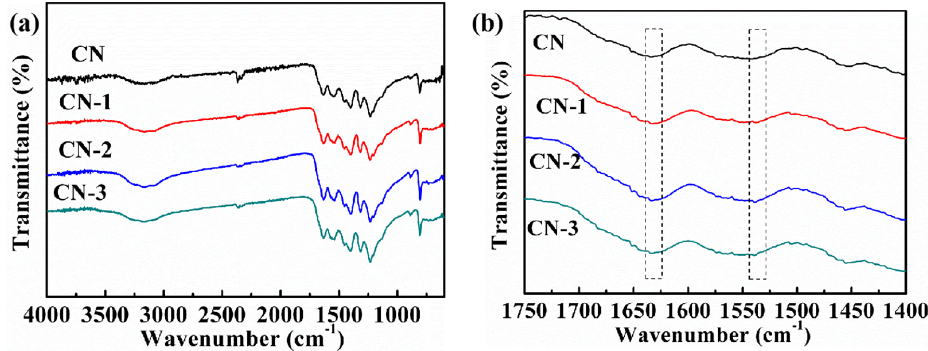
Figure 2. ( a ) FTIR spectra and ( b ) the enlarged FTIR spectra of the CN, CN-1, CN-2, and CN-3 samples